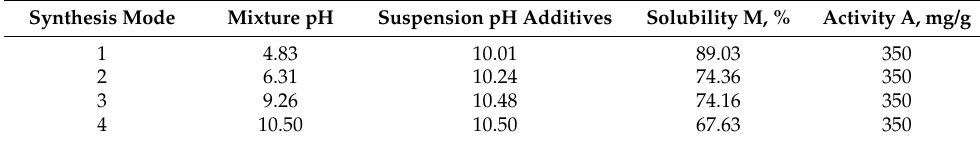
Table 5. Properties of additive based on synthetic aluminosilicates.